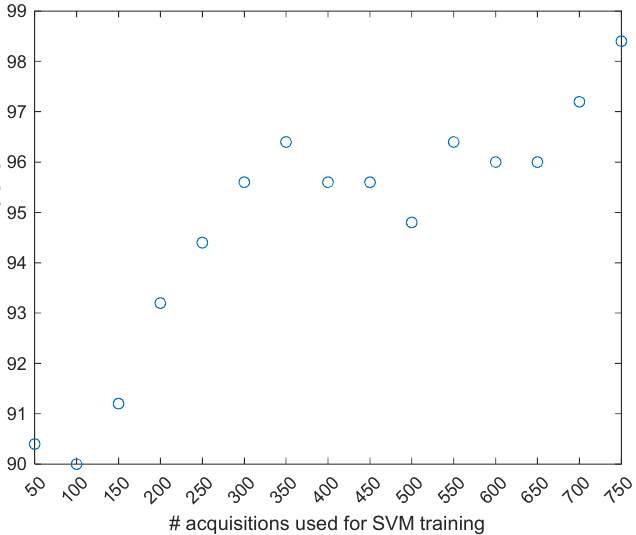
Figure 5. Accuracy of the SVM built for plate damage detection, as a function of the number of acquisitions used for training.